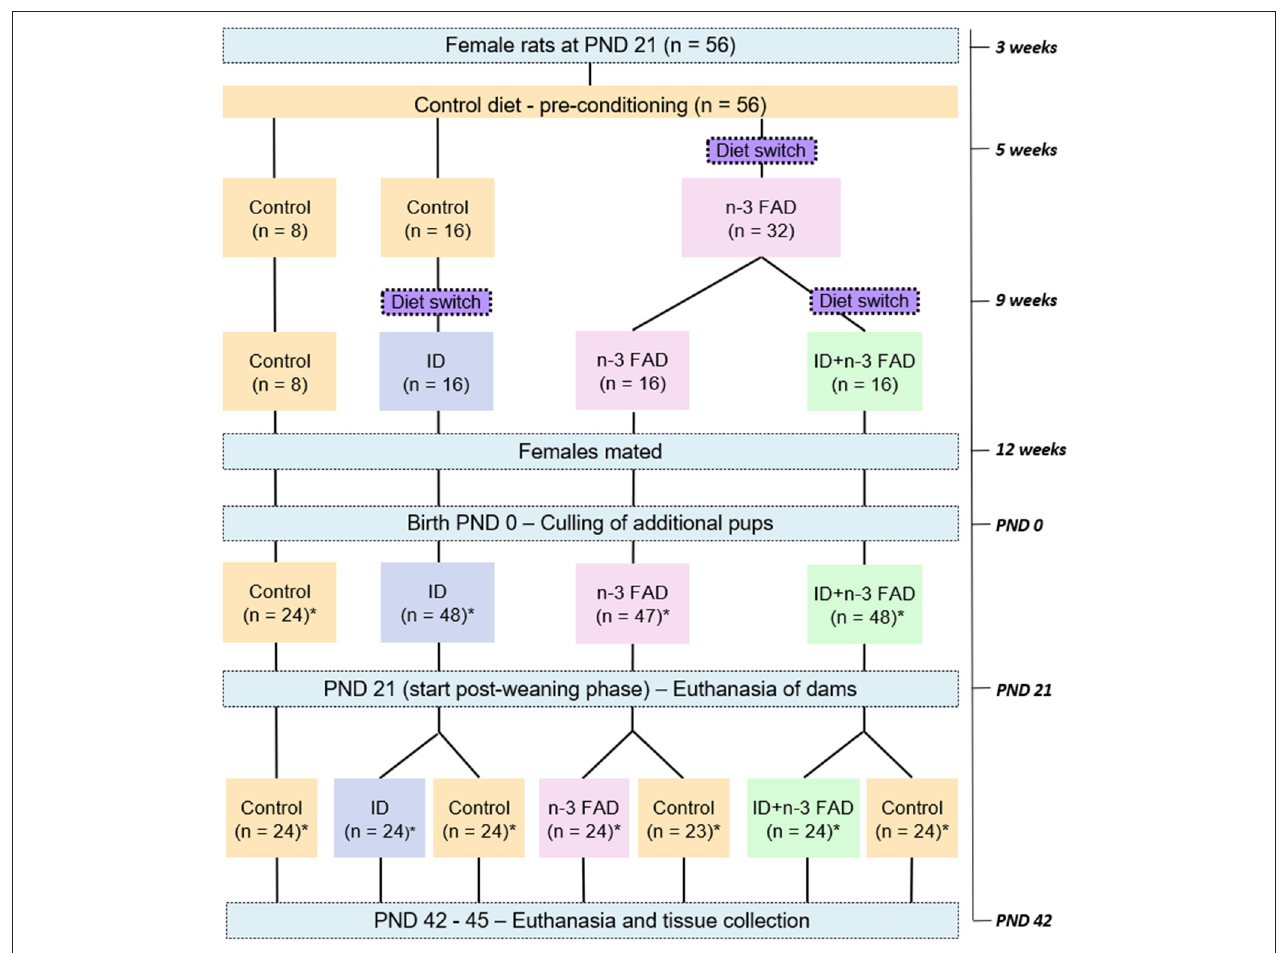
FIGURE 1 | Schematic diagram of the experimental design. n, number of rats; PND, post-natal day; ID, iron deficiency; n-3 FAD, omega-3 fatty acid deficiency; *equal male:female ratio.